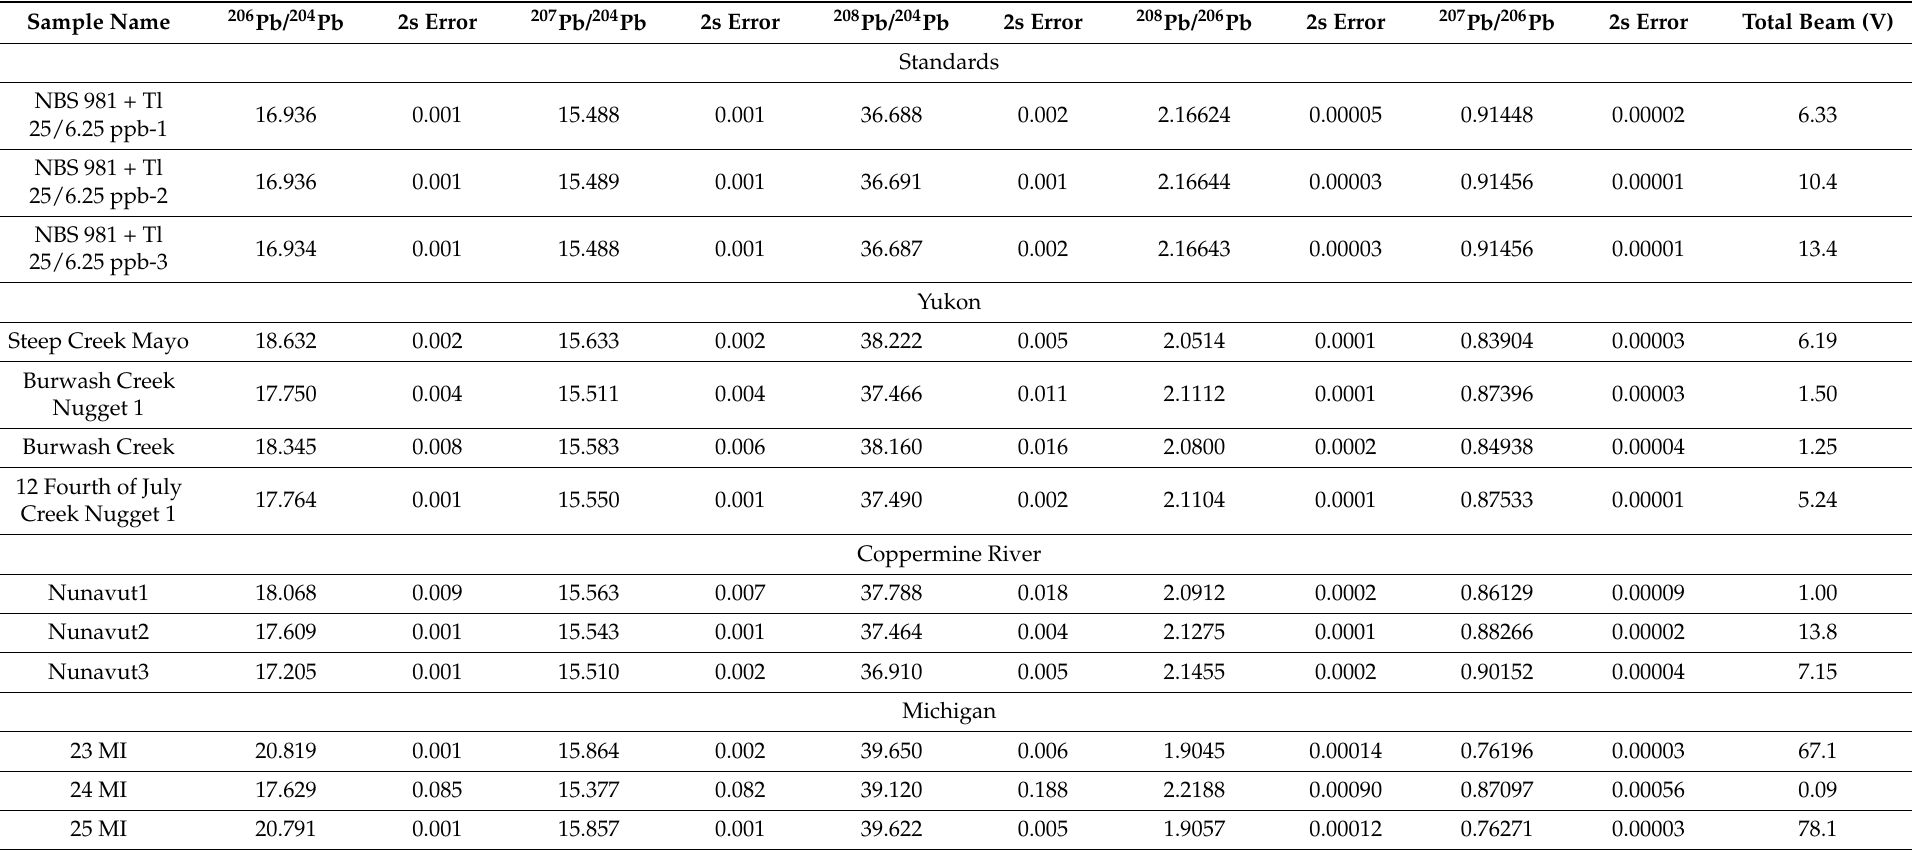
Table 1. Results of Native Copper